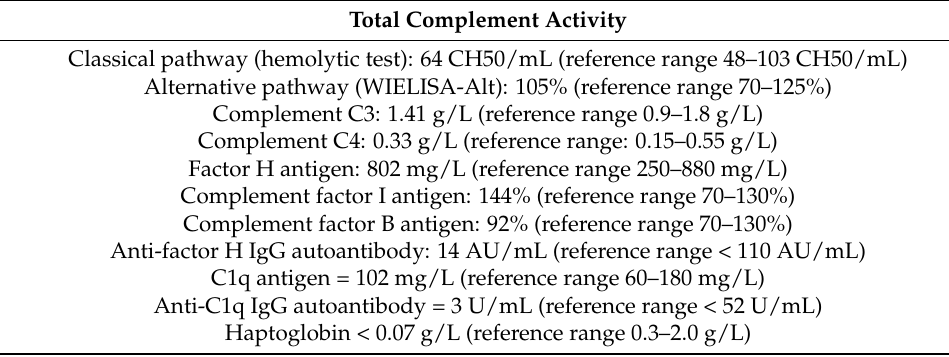
Table 5. Total complement activity analysis before treatment initiation for